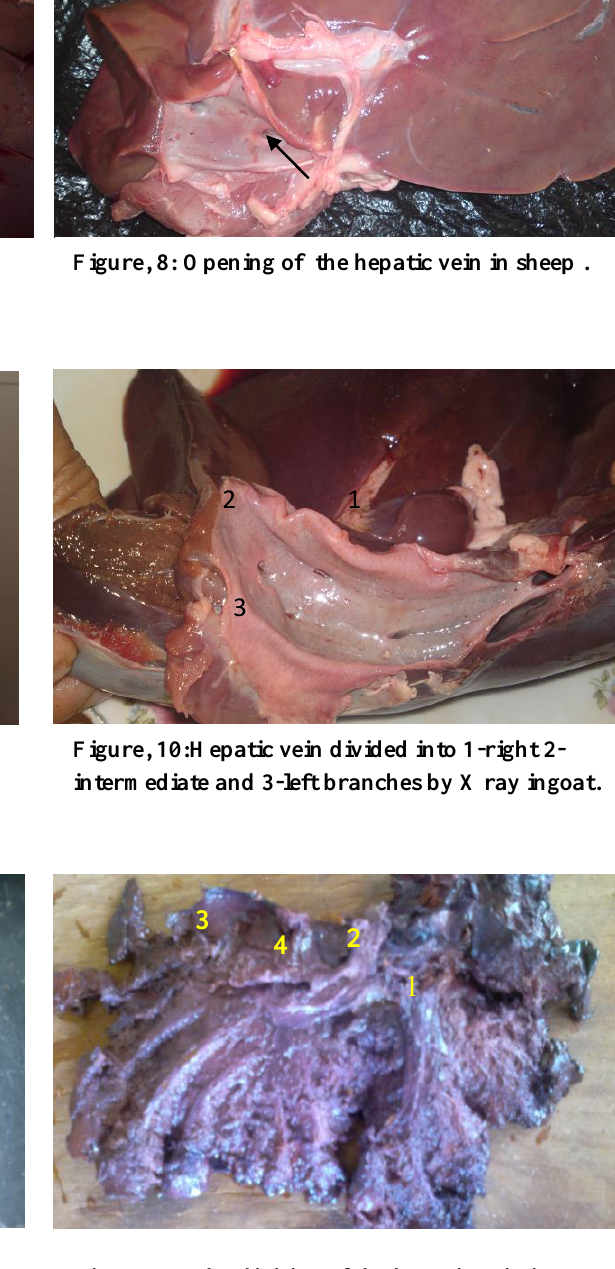
Figure, 12:The division of the hepatic vein into 1-right 2-intermediate 3-left and 4-papillary branches by cast in sheep.